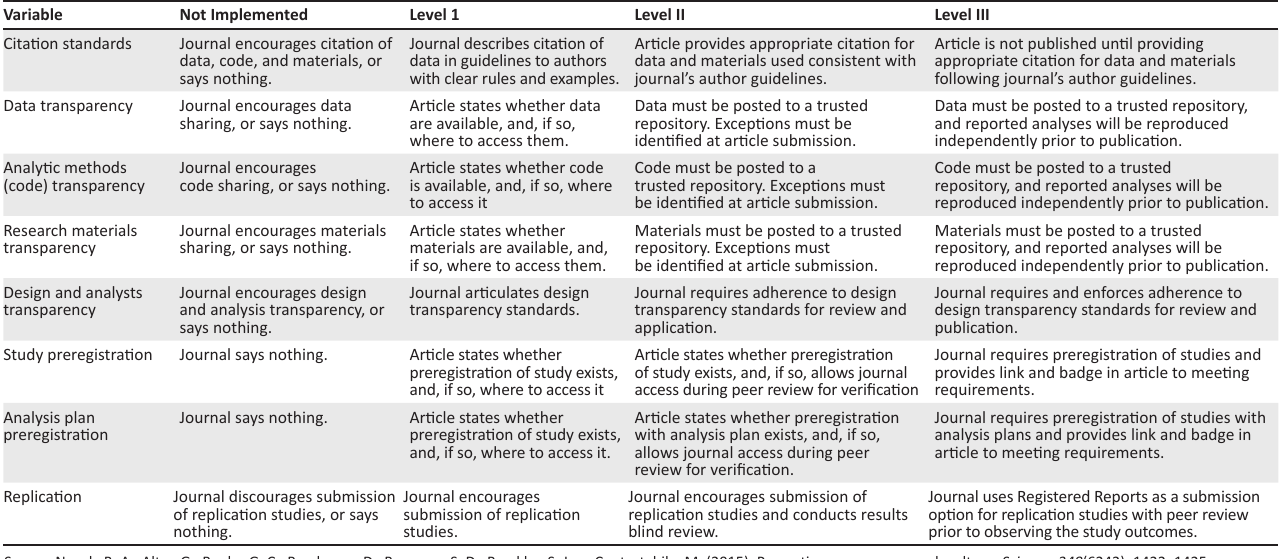
TABLE 2: Transparency and openness promotion guideline Standards and level (tiers) of adoption for transparent and open research. Variable Not Implemented Level 1 Level II Level